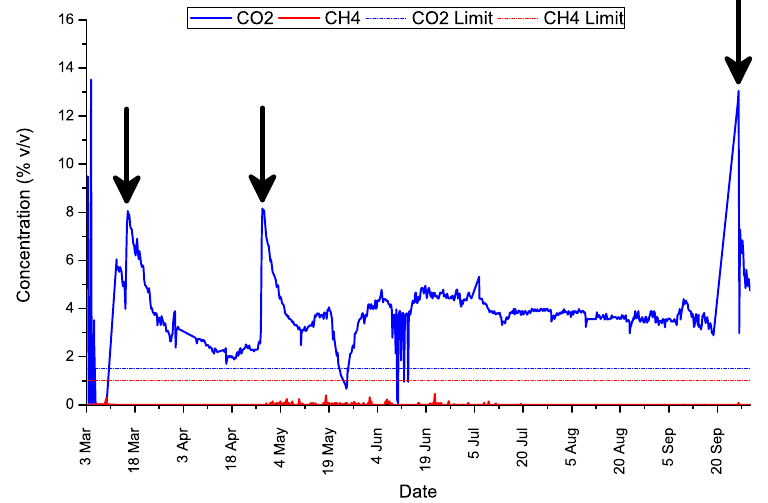
Figure 10. CO 2 and CH 4 readings from a 7 month field deployment at location C between March 2010 and October 2010. Note that CO 2 exceeds the recommended limit 96.6% of the time, while CH 4 never exceeds the recommended limit. The arrows on the graph illustrate significant CO 2 events that were recorded around the 17th of March, 28th April, and 25th of September. There were no CH 4